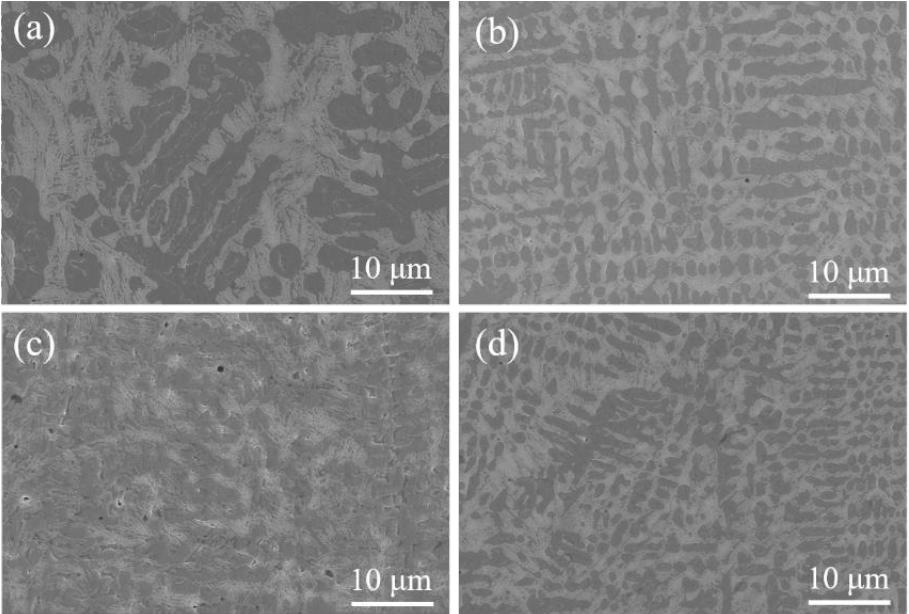
Figure 3. The SEM of coatings under different field-assisted types, ( a ) 1 # , ( b ) 2 # , ( c ) 3 # , ( d ) 4 # .